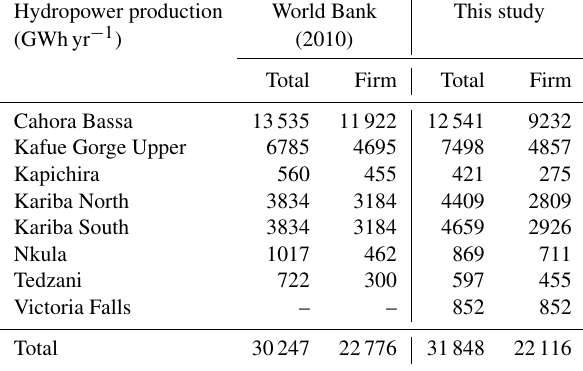
Table 7. Value of crop production in the Zambezi River basin. Data from FAO (2018) are at a national level, and are downscaled to the Zambezi River basin assuming constant per capita value; there- fore, the data might not be fully representative of the actual regional value.